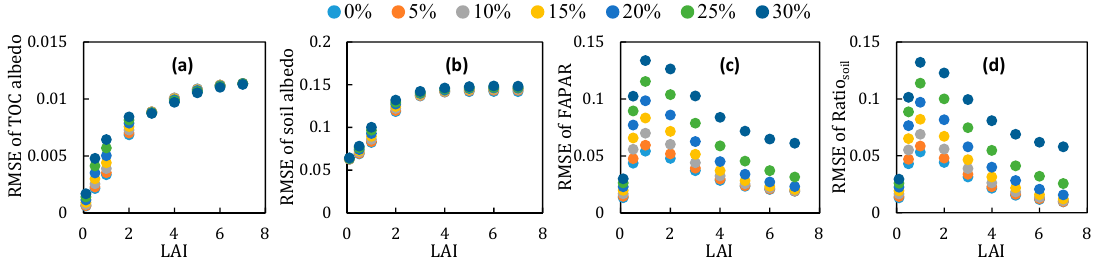
Figure 7. The mean RMSE of the retrieved TOC VIS albedo, soil VIS albedo, FAPAR, and soil-absorbed fraction of PAR using the EBR method for the 81,000 simulations with a Gaussian random noise in the LAI values (0% to 30%). Figures ( a – d ) correspond to the TOC VIS albedo, soil VIS albedo, FAPAR, and soil-absorbed fraction of PAR,